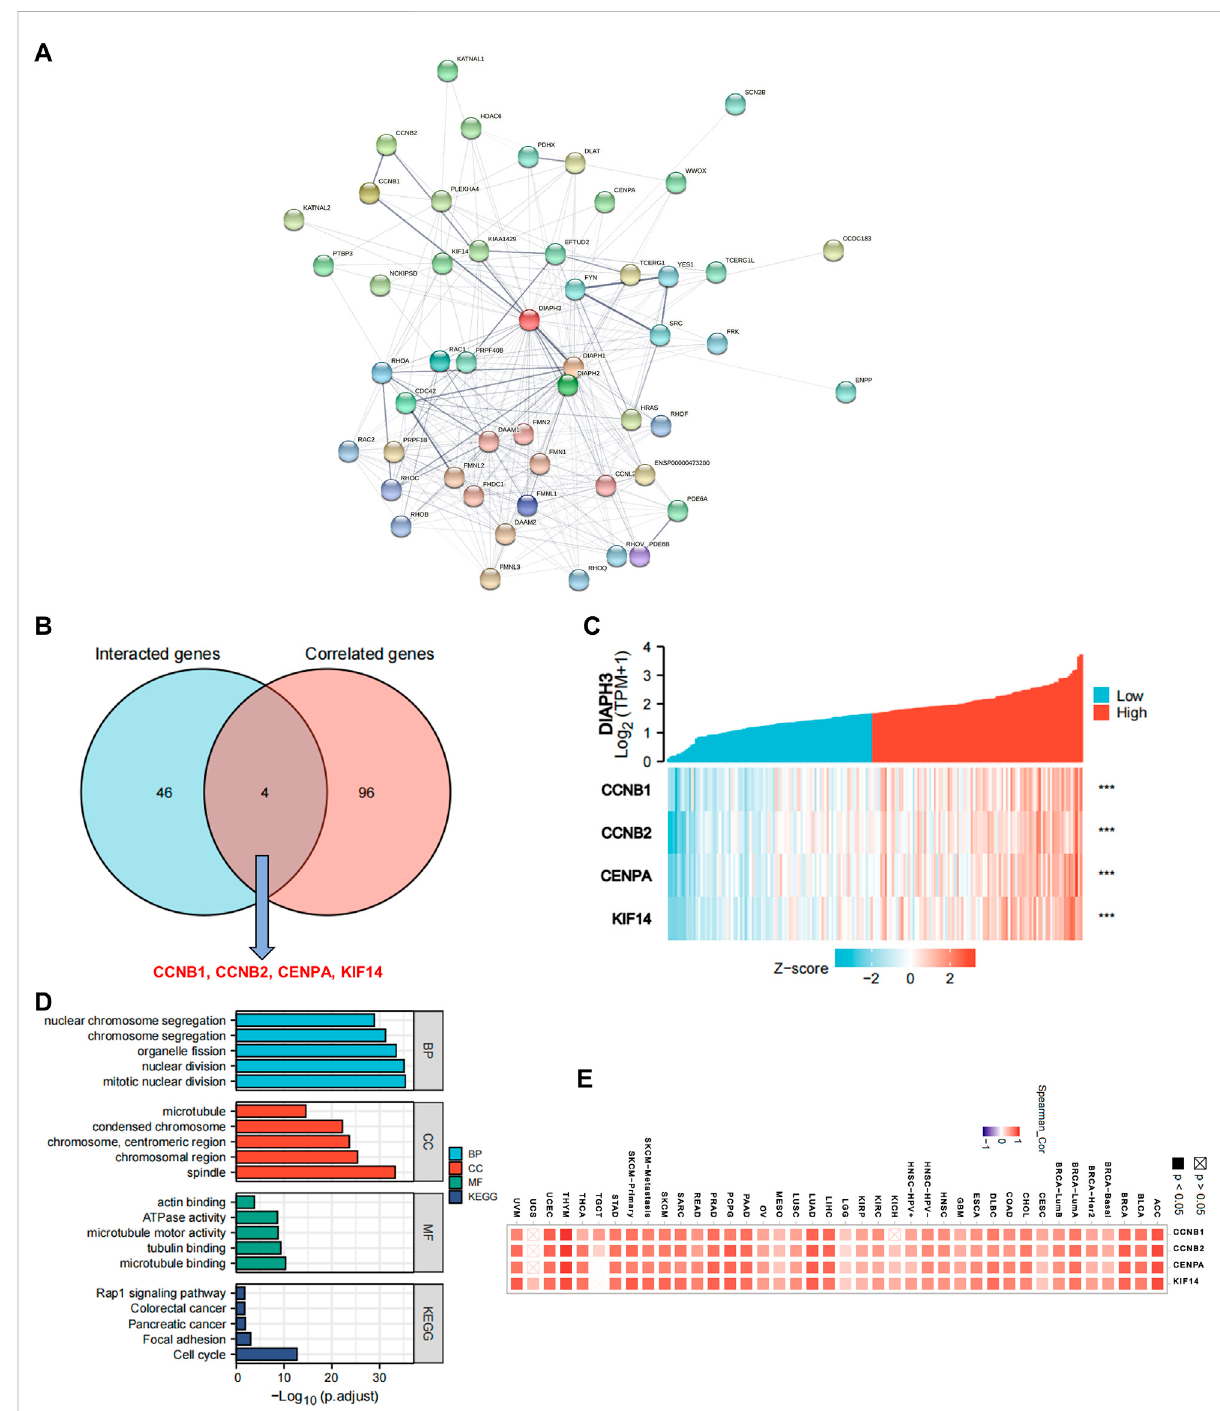
FIGURE 6 DIAPH3-related gene network, KEGG pathway analysis, and GO enrichment analysis. (A) A total of 50 available experimentally determined DIAPH3-interacting proteins using STRING tool. (B) An intersection analysis of the DIAPH3-interacting and -correlated genes. (C) The correlation between DIAPH3 expression and four intersected genes expression in PAAD. *** p < 0.001, in Spearman ’ s rho. TPM, transcripts per million. (D) GO enrichment and KEGG pathway analyses based on the DIAPH3-interacting and -correlated genes. Adjusted p -values were obtained from multiple hypotheses test using the Benjamini – Hochberg procedure; p . adjust < 0.05 was considered statistically signi fi cant. (E) Correlation between DIAPH3 and intersected four genes expression in pan-cancer, in purity-adjusted partial Spearman ’ s